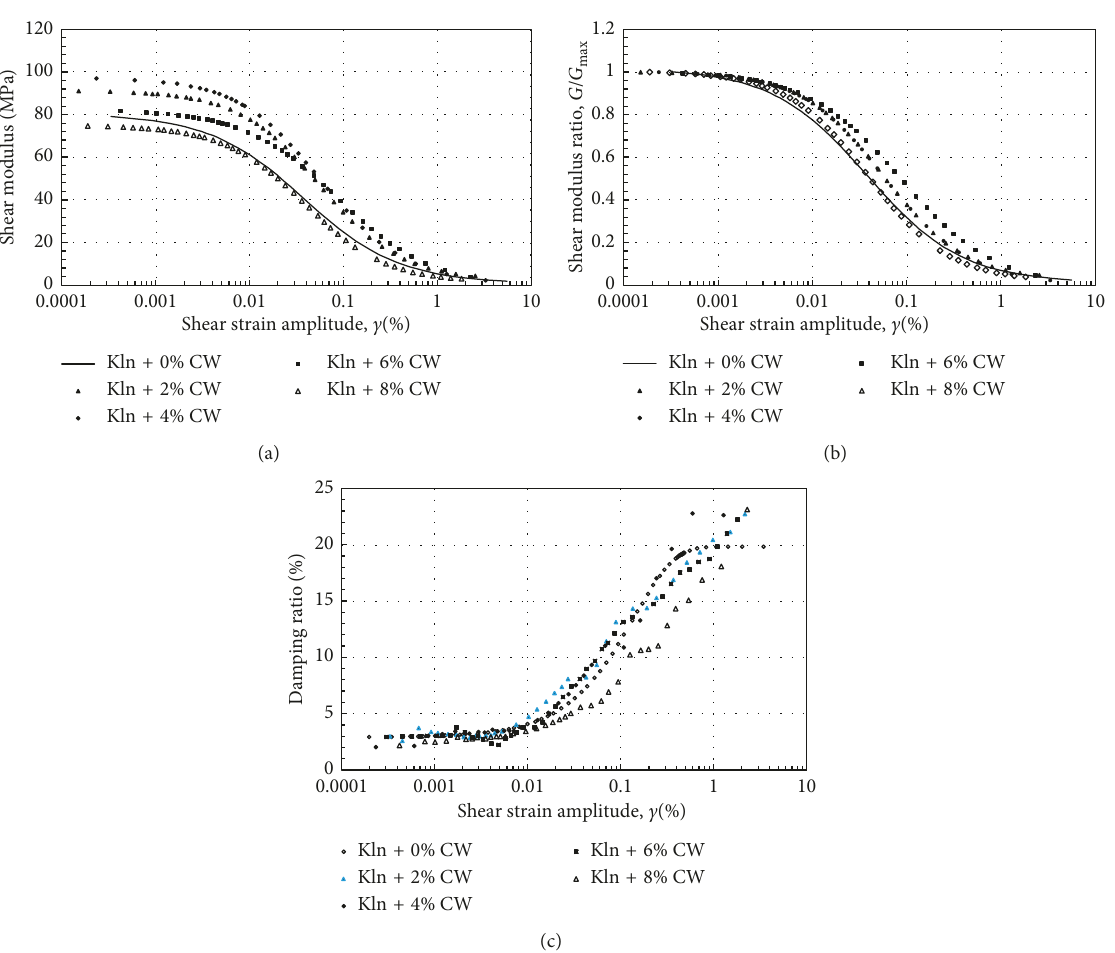
Figure 6: Comparison of (a) initial shear modulus, (b) shear modulus ratio, and (c) damping ratio of control samples.